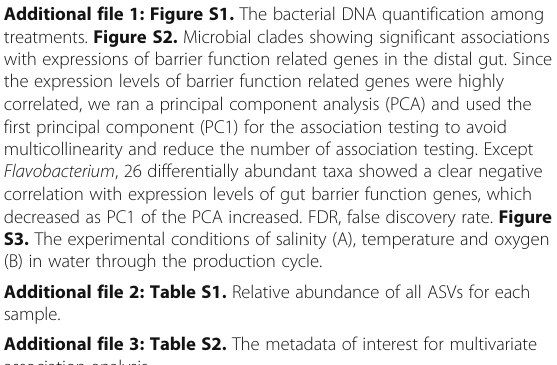
Additional file 1: Figure S1. The bacterial DNA quantification among treatments. Figure S2. Microbial clades showing significant associations with expressions of barrier function related genes in the distal gut. Since the expression levels of barrier function related genes were highly correlated, we ran a principal component analysis (PCA) and used the first principal component (PC1) for the association testing to avoid multicollinearity and reduce the number of association testing. Except Flavobacterium , 26 differentially abundant taxa showed a clear negative correlation with expression levels of gut barrier function genes, which decreased as PC1 of the PCA increased. FDR, false discovery rate. Figure S3. The experimental conditions of salinity (A), temperature and oxygen (B) in water through the production cycle. Additional file 2: Table S1. Relative abundance of all ASVs for each sample. Additional file 3: Table S2. The metadata of interest for multivariate association analysis. Abbreviations LAB: Lactic acid bacteria; PERMANOVA: Permutation multivariate analysis of variance; PCoA: Principal coordinate analysis; 16S rRNA: 16 Svedberg ribosomal ribonucleic acid; QIIME 2: Quantitative Insights Into Microbial Ecology 2; ASVs: Amplicon sequence variants; ANOVA: Analysis of molecular variance; il1 β : Interleukin-1 beta; ifn γ : Interferon gamma; tgf β : Transforming growth factor-beta; il10: Interleukin 10; cd3 γδ : Cluster of differentiation 3 γδ ; cd8 β : Cluster of differentiation 8 β ; myd88: Myeloid differentiation factor 88; PCA: Principal component analysis; PC1: Extracted the first